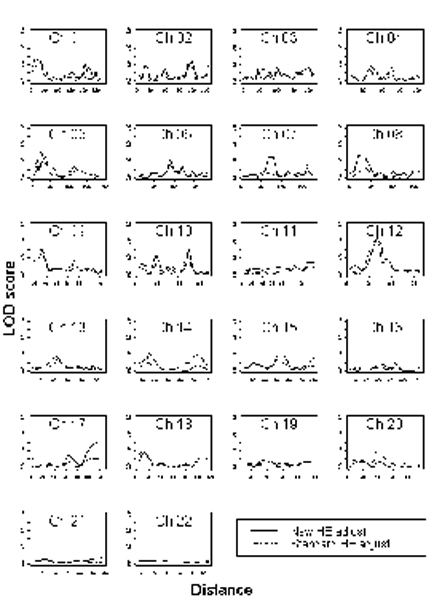
LOD scores based on longitudinal analyses The solid curves represent the multipoint LOD scores obtained after adjusting for gender, age, and drinking level using the adjusted HE method. The dashed curves represent the multipoint LOD scores obtained after adjusting for gender, age, and drinking level using the standard HE method in S.A.G.E.